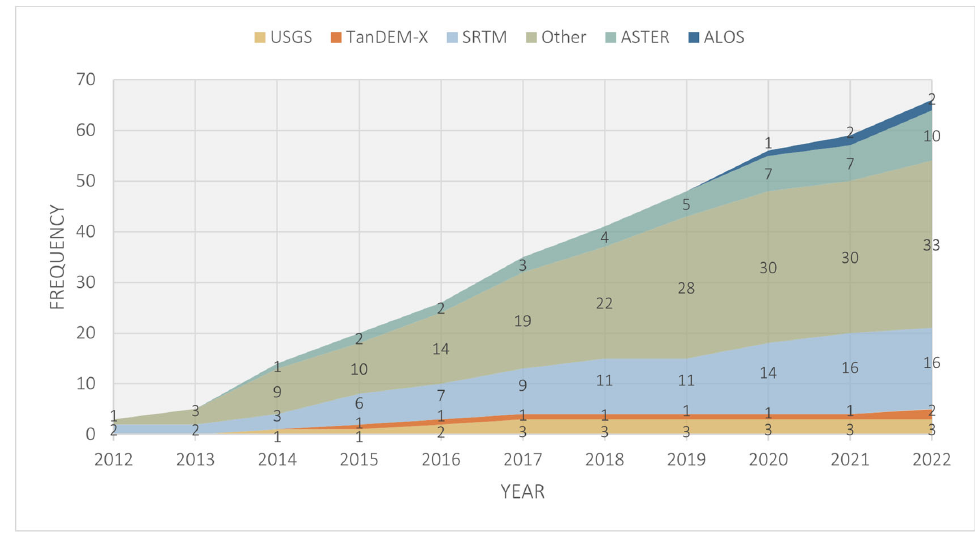
Figure 5. Cumulative DEM source.